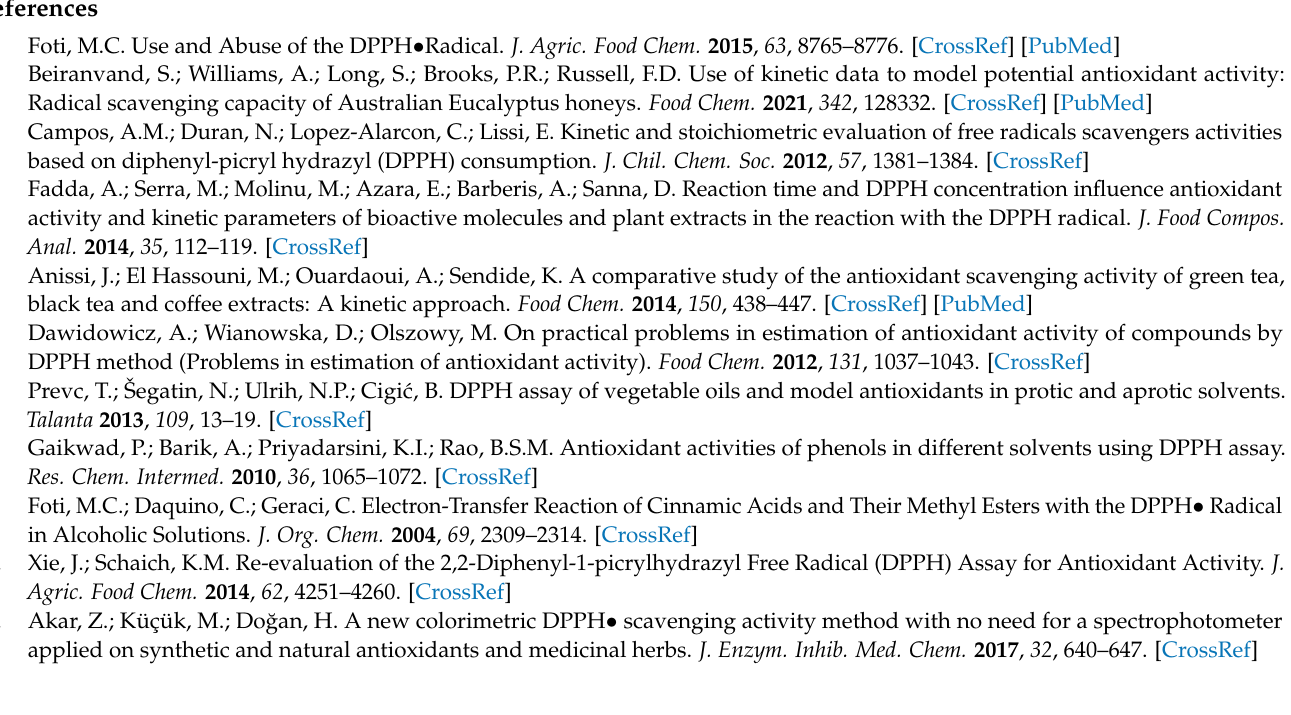
products, Figure S2: chromatographic peaks and mass spectra for sinapic acid products, Figure S3: chromatographic peaks and mass spectra for Trolox products, Figure S4: chromatographic peaks and mass spectra for chlorogenic acid